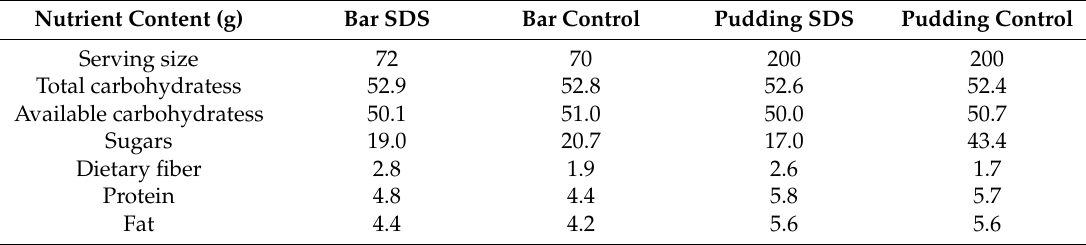
Table 1. Nutrient composition of cold-pressed bars and instant pudding. SDS: slowly digestible starch.